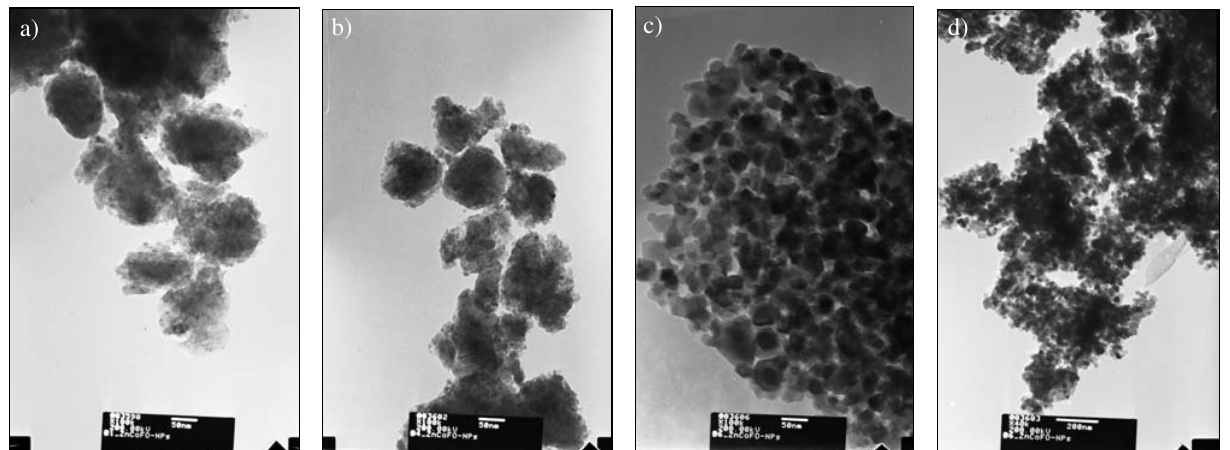
Figure 5. TEM-micrographs of ZC31/4 (a), ZC31/8 (b) x100k and ZC13/8 (c) and (d), respectively at x100k and x 40k.